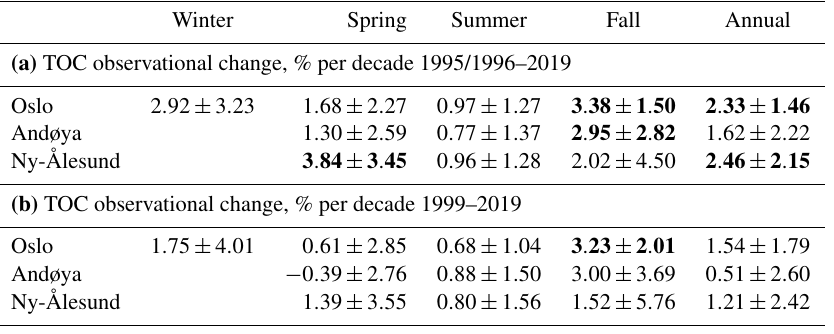
Table 6. Seasonal and annual changes in total ozone in Oslo, at Andøya, and in Ny-Ålesund for the period (a) 1995–2019 (start year 1996 for Andøya and Ny-Ålesund) and (b) 1999–2019. Uncertainty is expressed as 2 · SD (2 σ ). Results that are statistically significant are marked in bold.